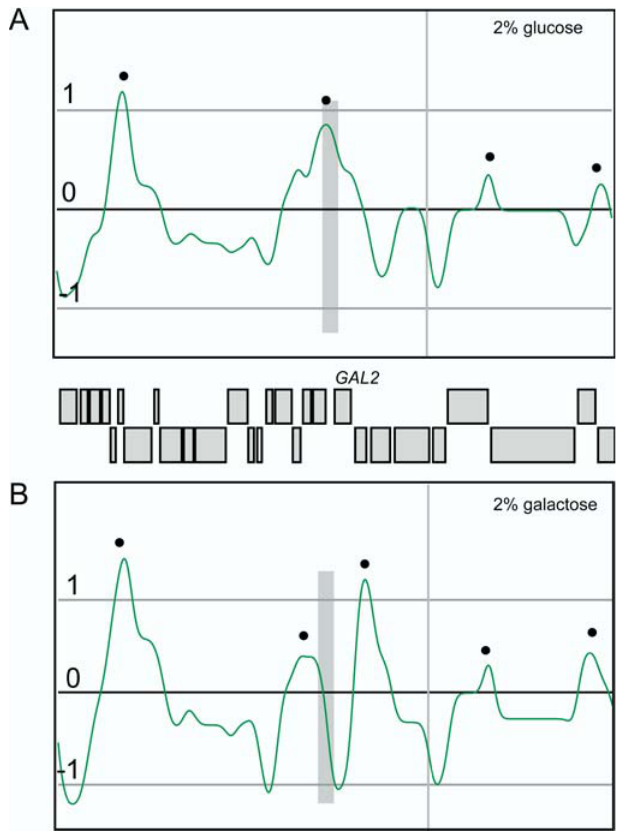
Figure 6. Transcription Affects the Cohesin Peak at the Promoter of GAL2 SGD coordinates 260–320 kb (x-axis) and a gene map are depicted for Chromosome XII. The strain 1827-22D (isogenic to the strain in Figure 1 except CDC16 ) was grown with either 2% glucose (A) or 2% galactose (B) as the carbon source. Cultures were arrested with nocodazole, and ChIP chip was performed. The smoothed data (as the log 2 of the ratio) is depicted in green, the peaks found by PeakFinder are indicated with black dots, and the region corresponding to the GAL2 promoter is indicated with a grey bar. Transcription of GAL2 is up-regulated 42-fold in (B). DOI: